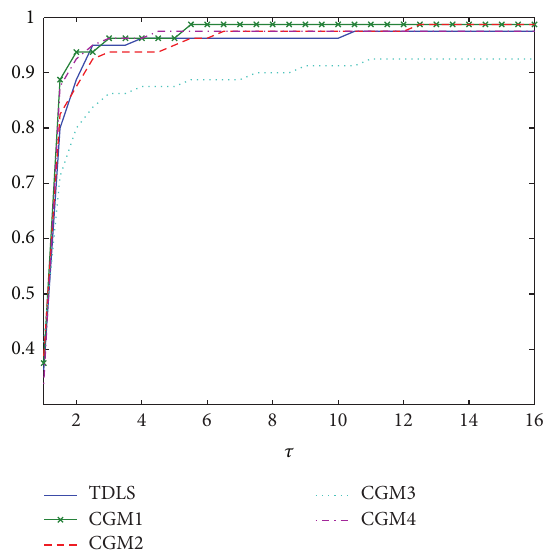
Figure 2: Performance profile based on the number of gradient evaluations.